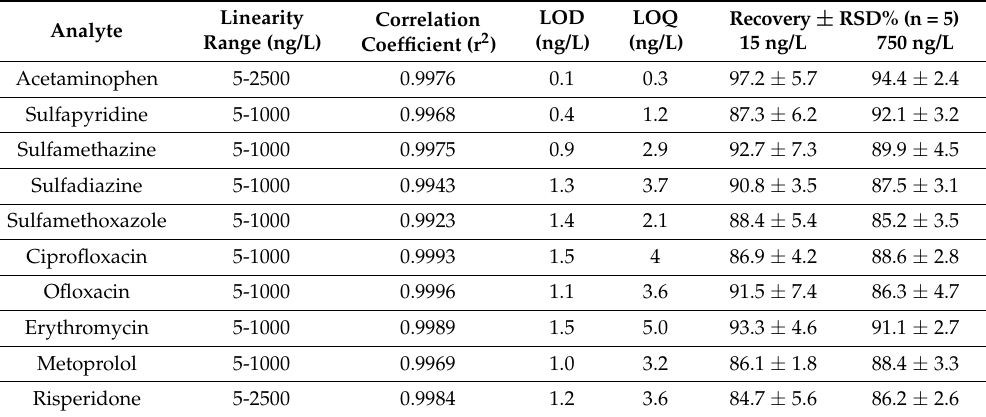
Table 4. Linearity ranges, LOQs, LODs and % recoveries of the selected